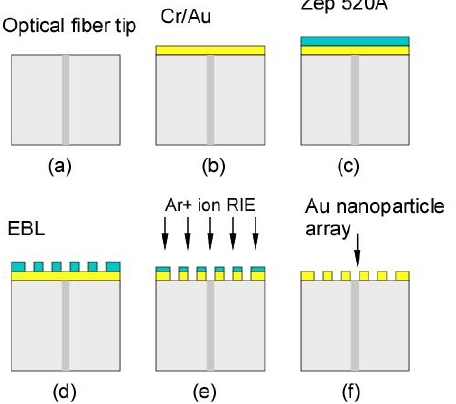
Figure 1. Illustration of fabrication process for gold nanodots array on the optical fiber